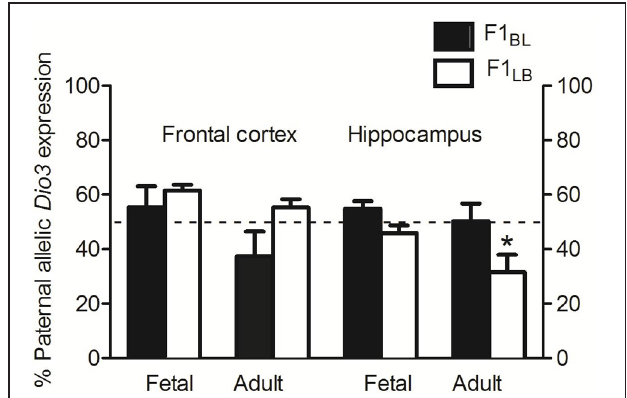
FIGURE 4 | Hippocampal-specific maternal Dio3 allelic expression in LB reciprocally crossed offspring with anxiety-related behavior. LB animals exhibit differential Dio3 allelic expression in hippocampus only, while BL offspring show no significant deviations from the expected allelic expression pattern of Dio3 in either brain region. Data represent means of individual animals’ Dio3 allelic expression values determined by quantitative pyrosequencing of cDNAs from each brain region. Results from animals that underwent behavioral testing did not differ from naïve animals. N = 12–14 individual fetal frontal cortex/strain, and N = 12–14 individual fetal hippocampal regions/strain. N = 12–13 individual adult frontal cortex/strain, and N = 13–15 individual adult hippocampal regions/strain. Data were first analyzed by Two-Way ANOVA using strain, sex, developmental stage, and brain region as factors where applicable. Data were pooled and re-analyzed by t -test if there was no interaction and no effect of either strain or sex in the initial analysis, or to test specific hypotheses. Data are males and females combined unless otherwise noted. ∗ p < 0 . 05 vs. frontal cortex, Bonferroni